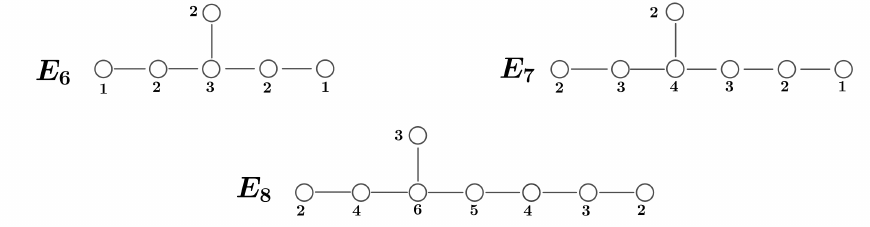
Figure 7 . Dual Coxeter labels for the E